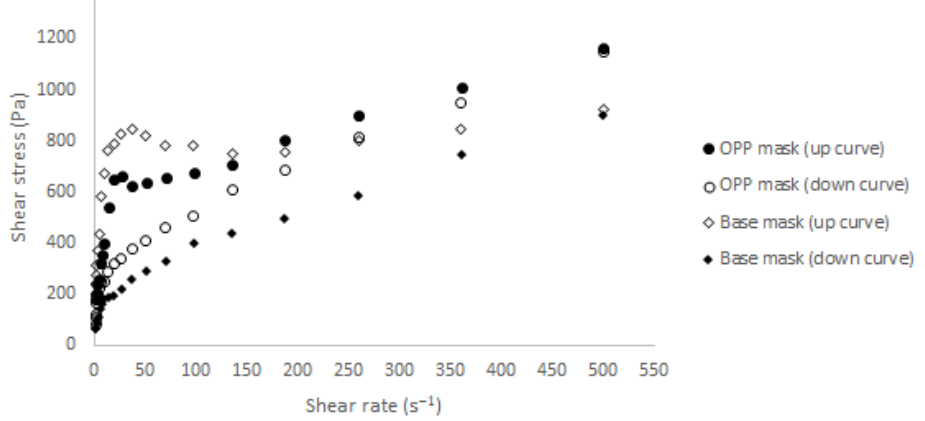
Figure 3. Rheograms, obtained for the control and 5% SSP-containing mask, at 20.00 ± 0.04 ° C.